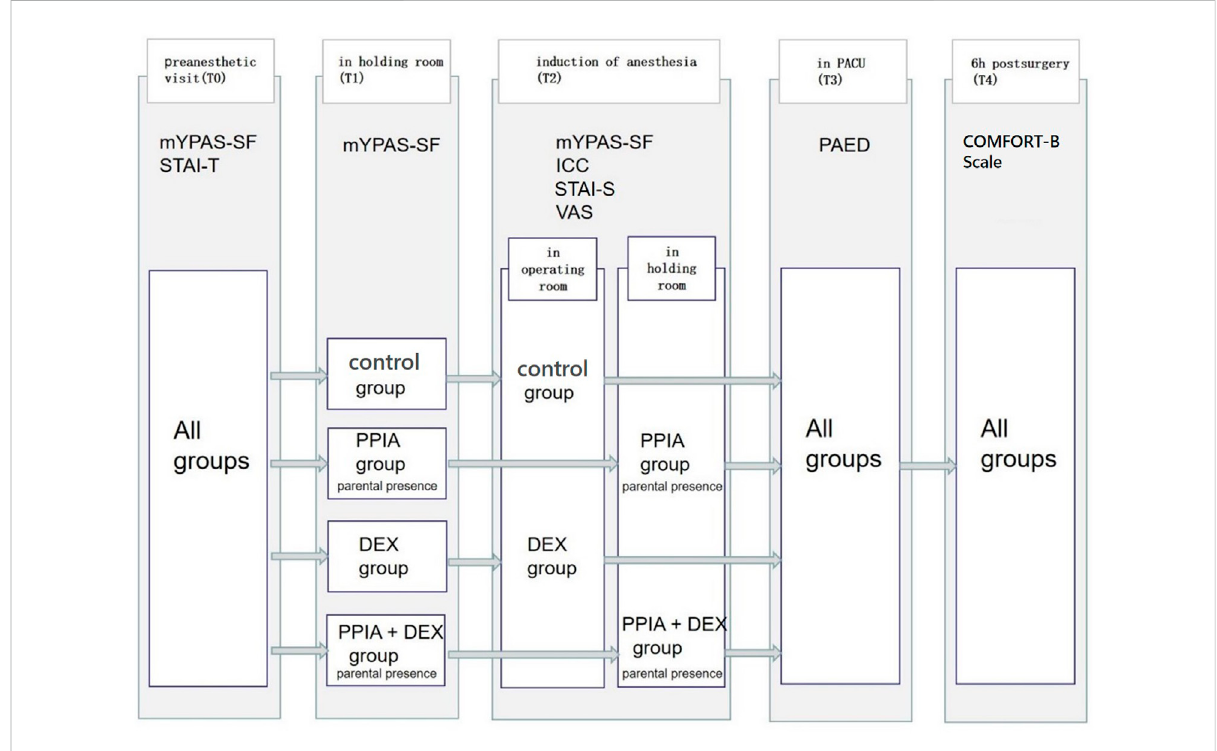
FIGURE 1 Study timeline. mYPAS-SF (modi fi ed Yale Preoperative Anxiety Scale-Short Form); ICC (Induction Compliance Checklist); STAI-T (State-Trait Anxiety Inventory-Trait); STAI-S (State-Trait Anxiety Inventory-State); PAED (Pediatric Anesthesia Emergence Delirium Scale); COMFORT-B Scale (The COMFORT Behavior Scale); VAS (Visual Analog